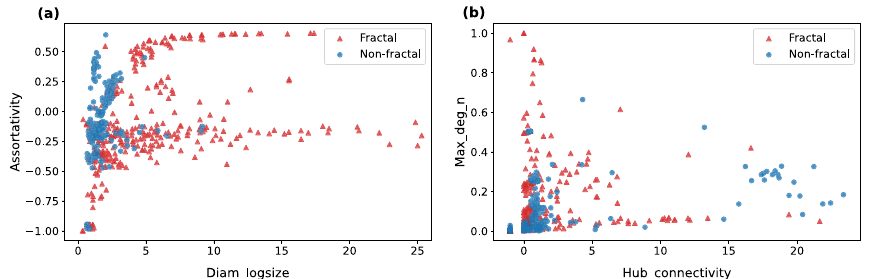
Fig. 26 Scatter plots of the dataset consisting of both real and model generated networks, with respect to two selected important features. a Assortativity coefficient plotted against the normalized diameter. b Normalized maximum degree plotted against the hub connectivity